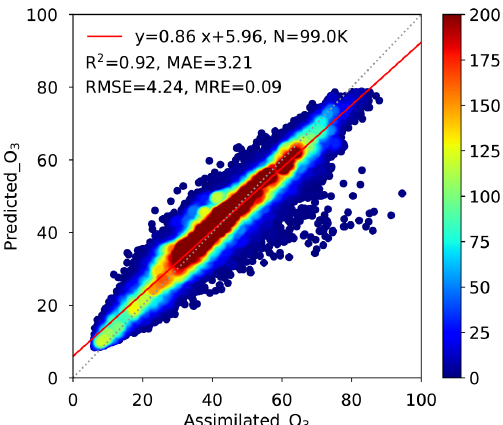
Figure 3. Density scatterplots of predicted vs. assimilated monthly near-surface O 3 concentrations (ppb) in 2019 over Asia. The gray and red lines are the 1 : 1 line and linear regression line, respec- tively. Statistical metrics including the number of samples ( N ), correlation of determination ( R 2 , unitless), root mean square error (RMSE, ppb), mean absolute error (MAE, ppb), and mean relative error (MRE, %) are shown at the top